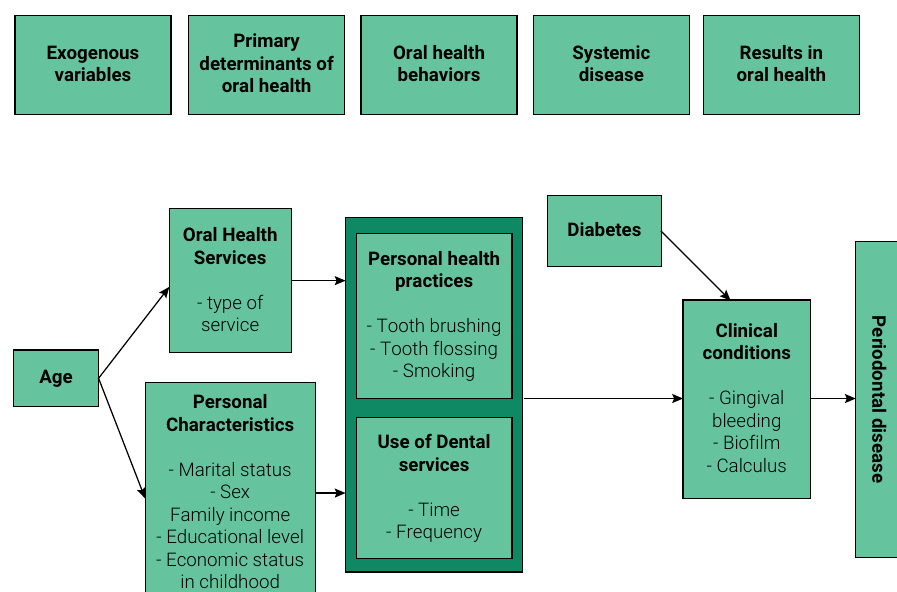
Figure 2. Conceptual framework for oral health-related qualify of life adapted from Batista MJ et al.,